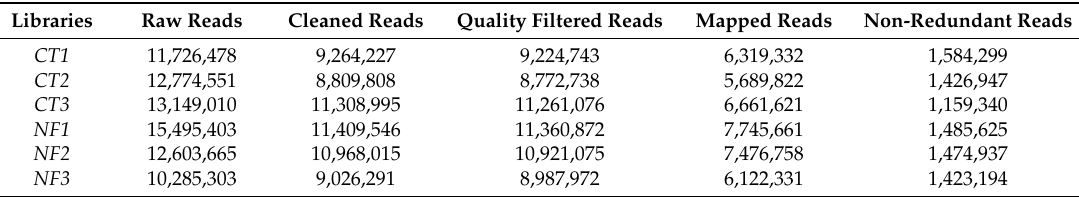
Table 1. Statistics of the small RNA libraries.